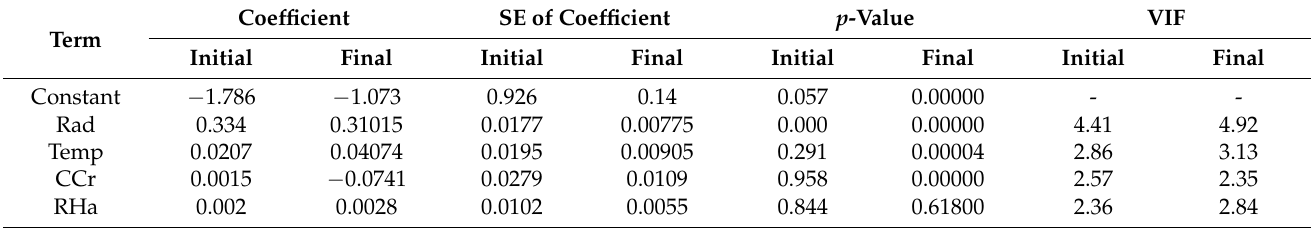
Table 6. Summary of the model statistics for the constant term and different predictor variables used.